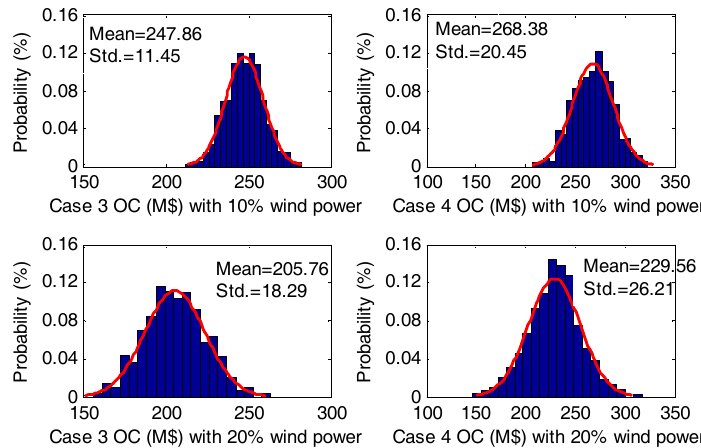
Figure 7. Operation cost (OC) distributions for cases 3 and 4 with increasing wind power.